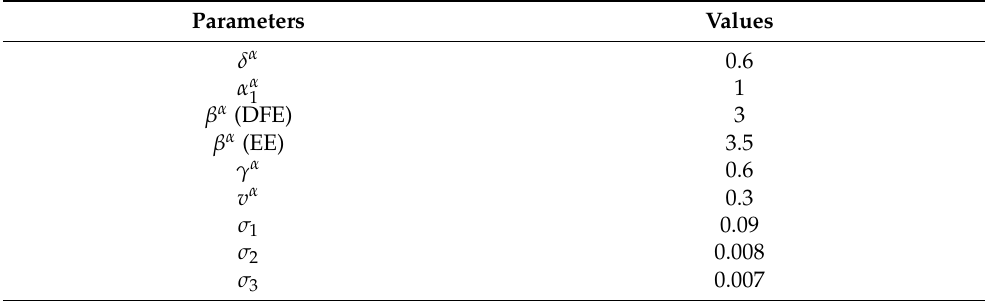
Table 1. Model parameters employed in the simulations of this work. Here, DFE stands for disease- free equilibrium, and EE for endemic